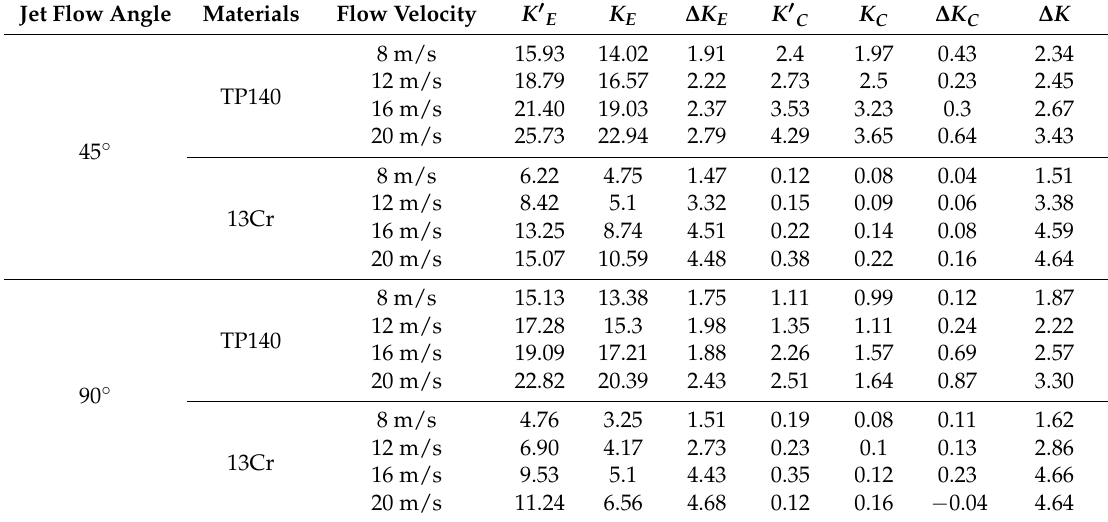
Table 4. Summary of experimental measurements of erosion and corrosion components (mm/a).